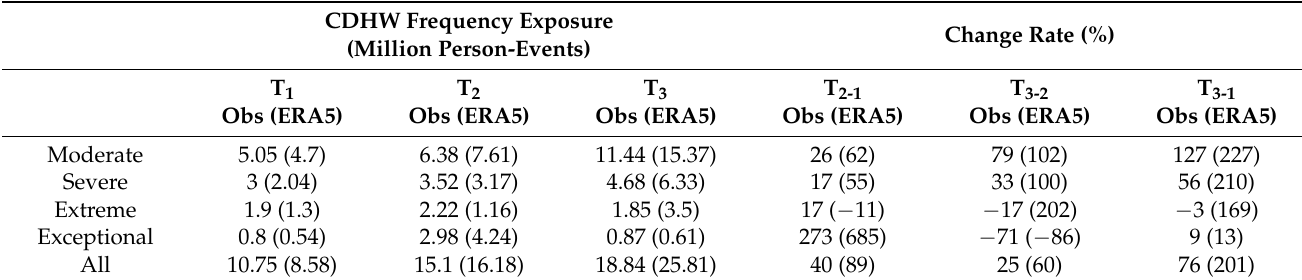
Table 1. Population exposure to CDHW frequency and the change rates.